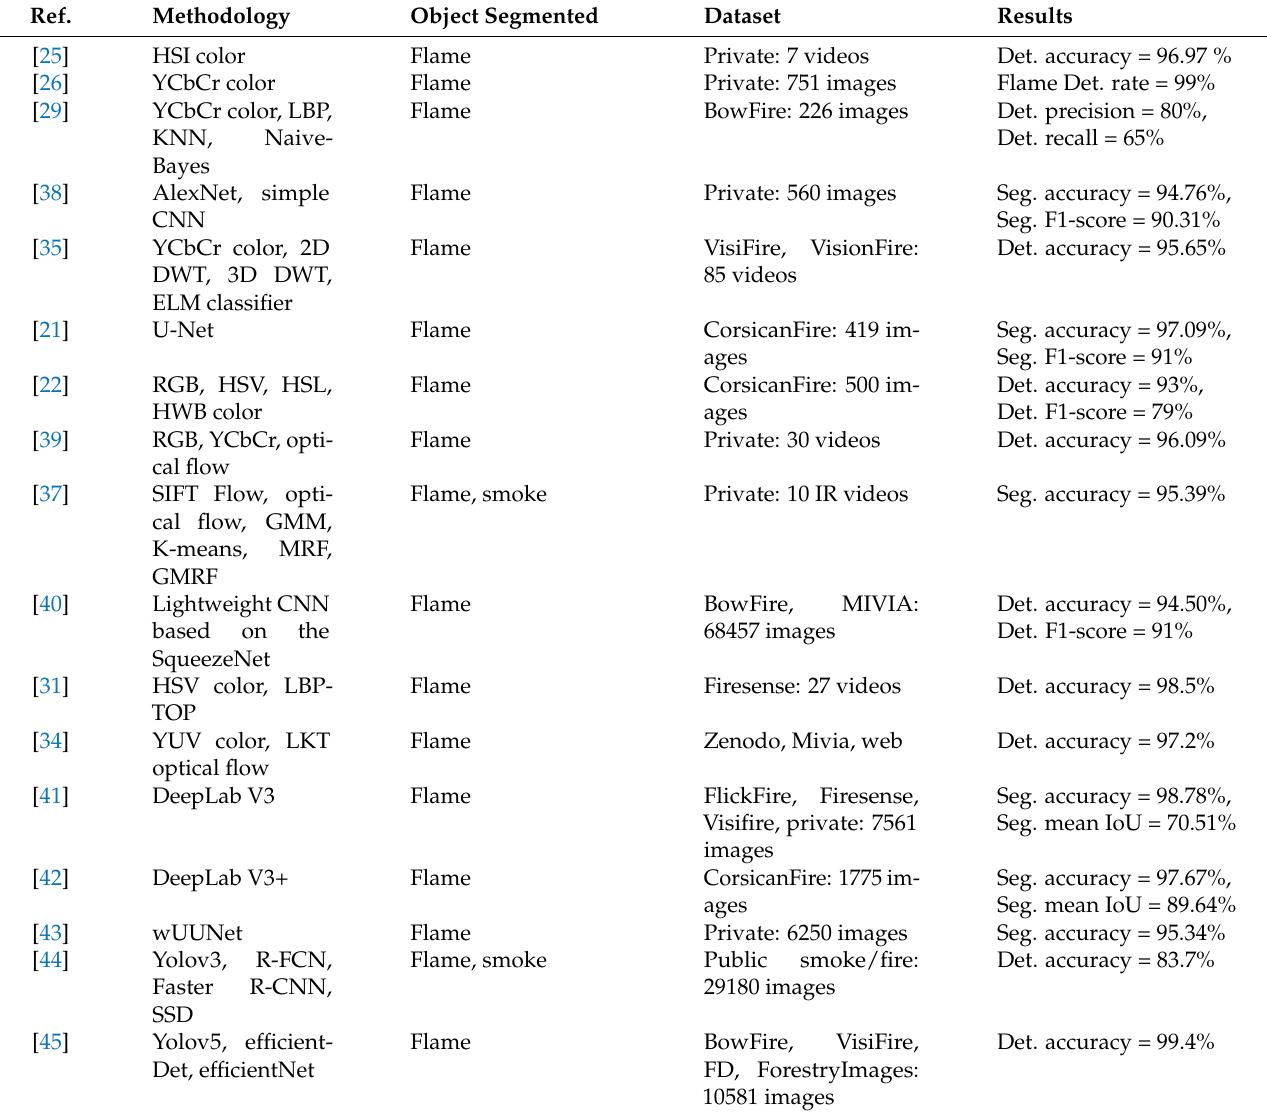
Table 1. Fire detection and segmentation methods (Seg. represents the segmentation techniques and Det. represents the detection techniques). Ref.